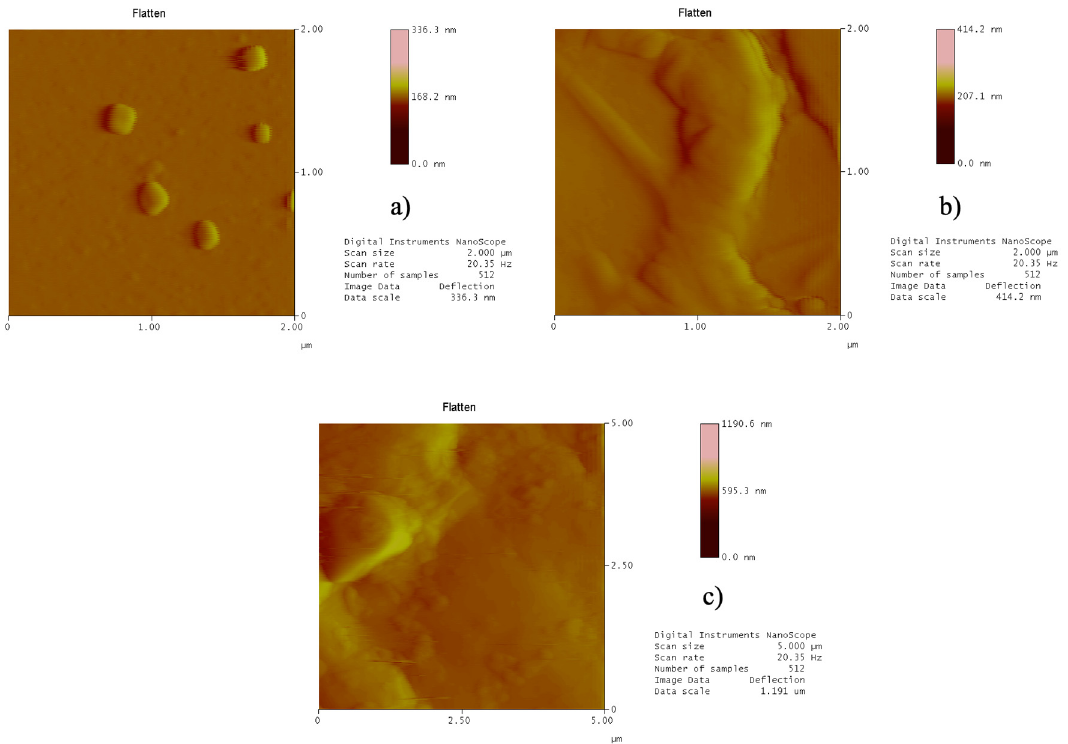
Figure 5. The Atomic Force Microscopy (AFM) images of ( a ) Graphene product obtained in dimethyl sulfoxide (G-DMSO), ( b ) Graphene product obtained in N,N-dimethyl formamide (G-DMF), and ( c ) Graphene product obtained in perchloric acid (G-PA) drop casted onto a glass piece showing the homogeneous structure of the pristine graphene nanosheets.